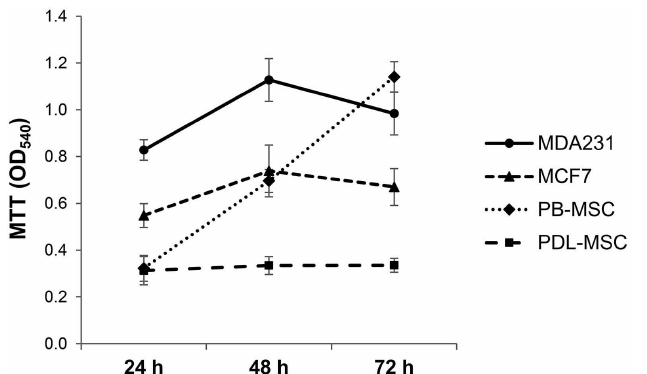
Figure 7. MTT test assayed spontaneous proliferation/viability of human breast cancer cells MDA 231 and MCF-7, and primary human periodontal ligament and peripheral blood mesenchymal stem cells (PDL-MSC and PB-MCS) in short-term cell